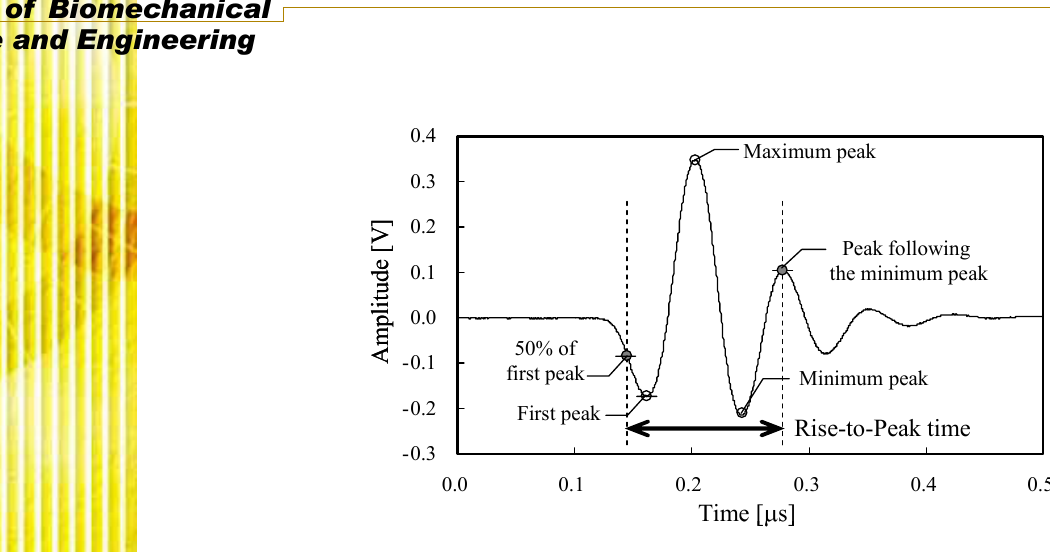
An incident wave per unit area of the probe surface is expressed as